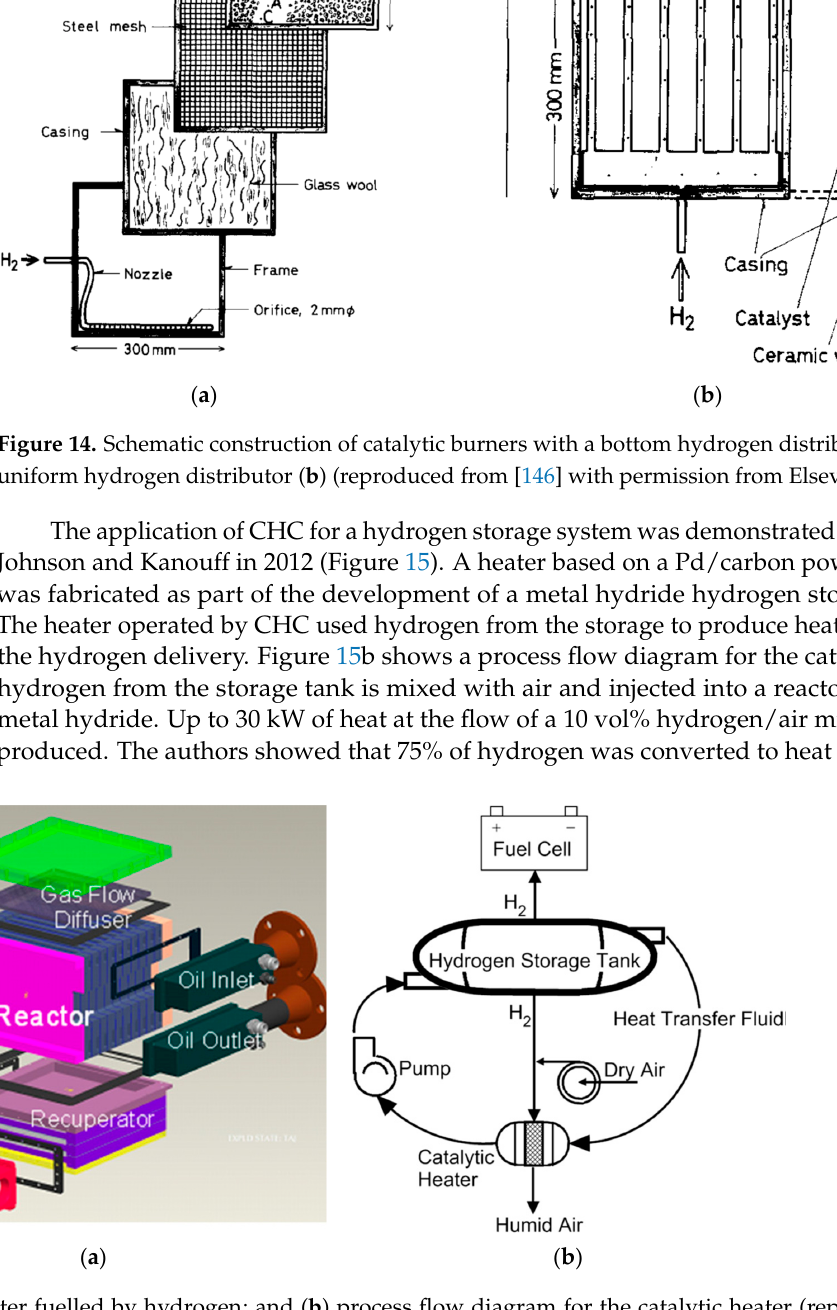
Figure 15. ( a ) Catalytic heater fuelled by hydrogen; and ( b ) process flow diagram for the catalytic heater (reproduced from [179] with permission from